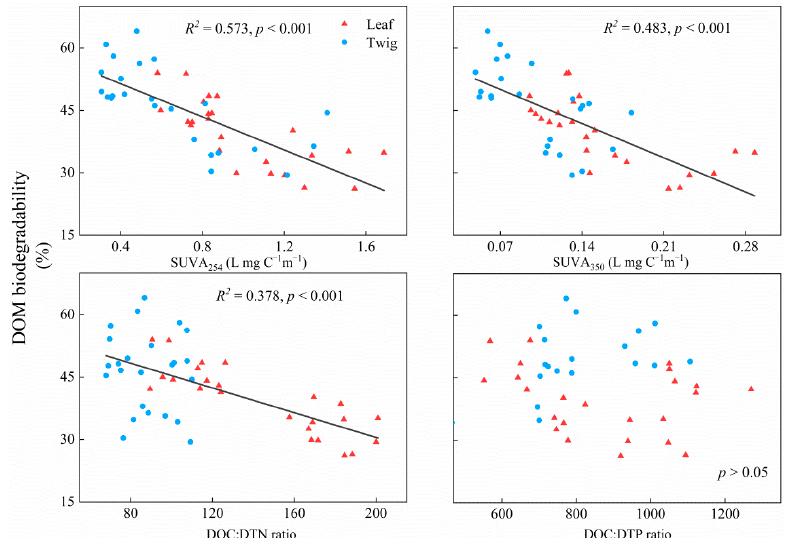
Figure 2. Relationships between plant-leached dissolved organic matter (DOM) biodegradability and the initial properties in subtropical plantations in southern China.